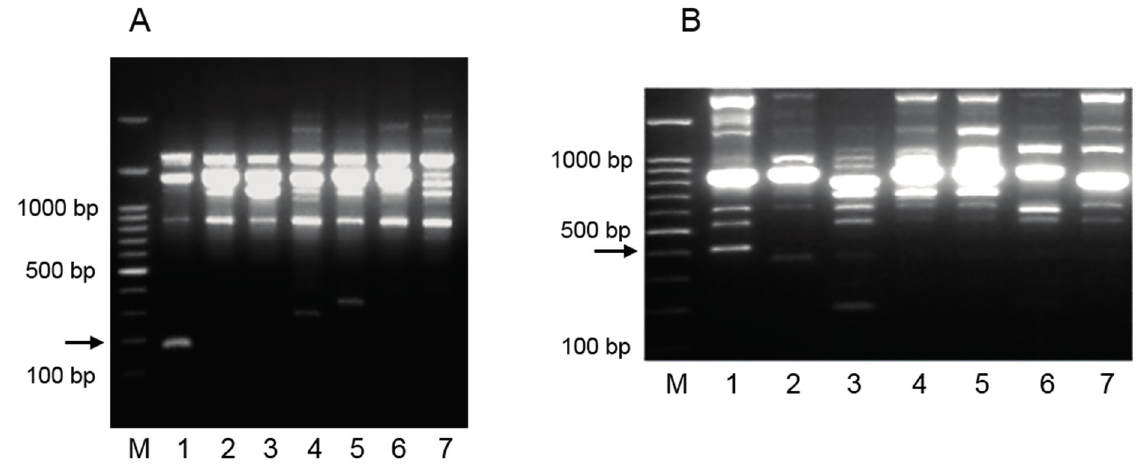
Figure 1. RAPD analysis for L. plantarum strains 2035 and ACA-DC